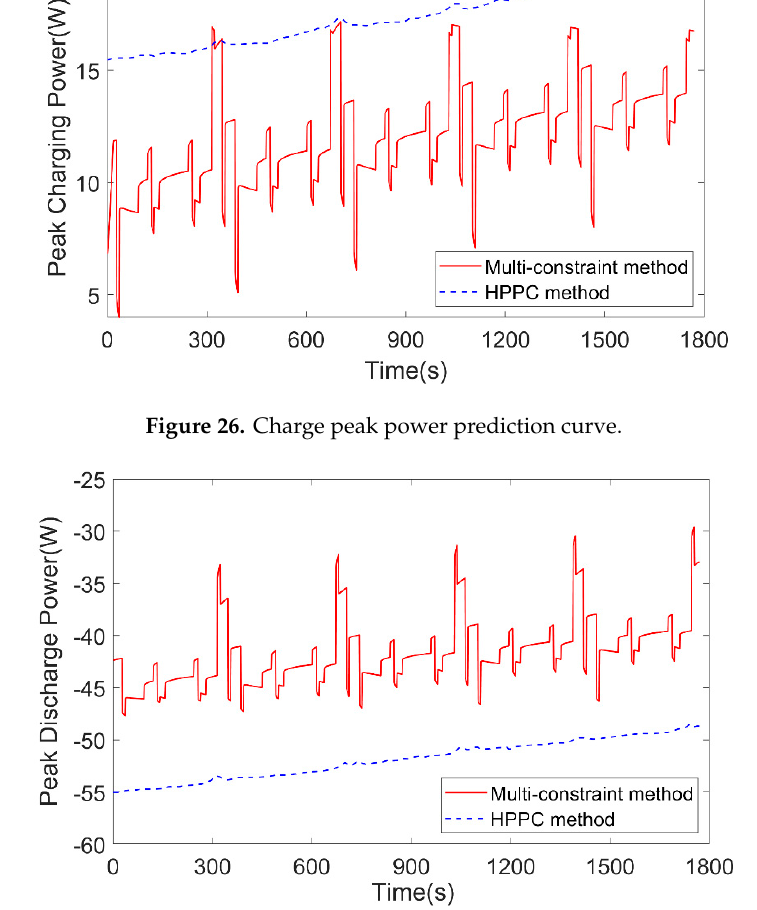
Figure 27. Discharge peak power prediction curve.